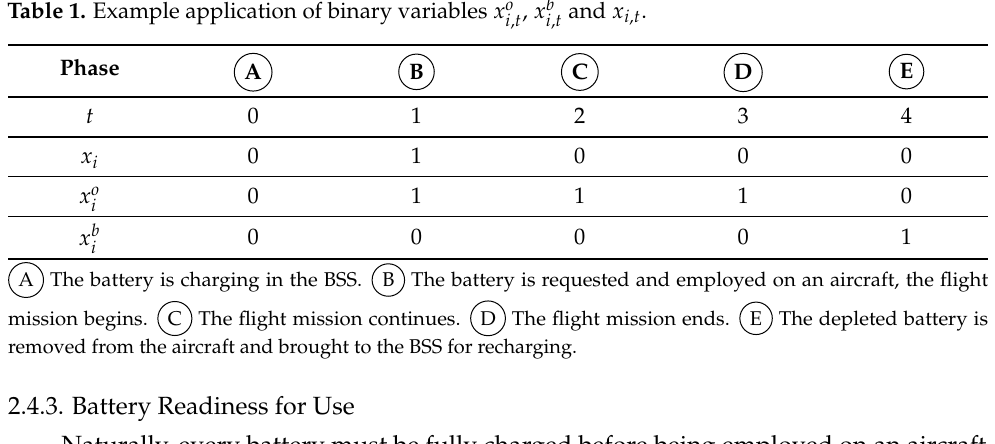
Table 1. Example application of binary variables x o